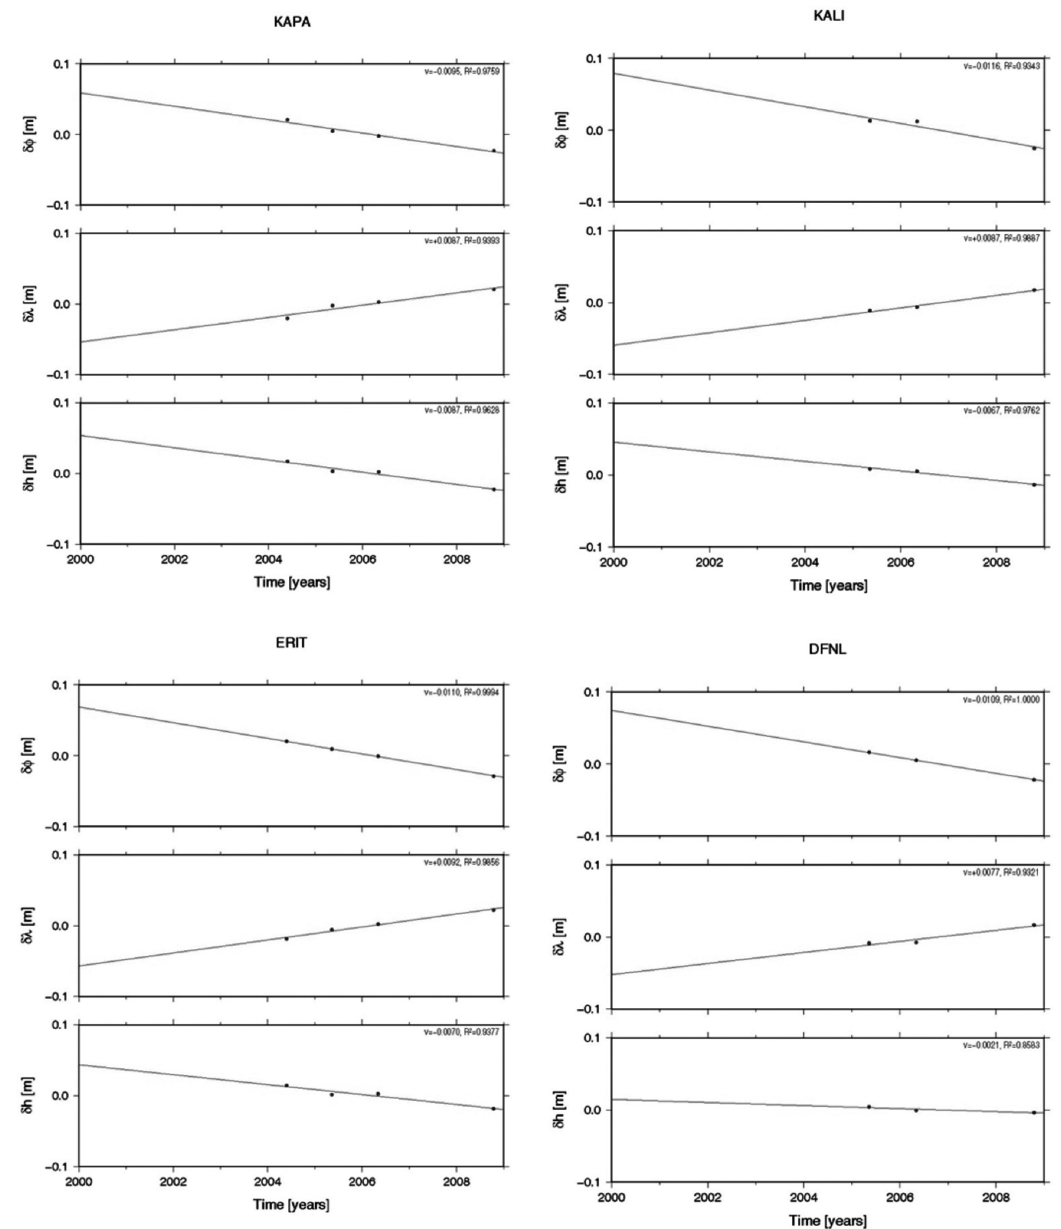
Figure 4. Graph with position time series (N, E, UP from top to bottom) from stations with 4 epochs of observations (KAPA and ERIT; a and c) and 3 epochs of observations (KALI and DFNL; b and d), respectively. Location of stations is shown in Figure